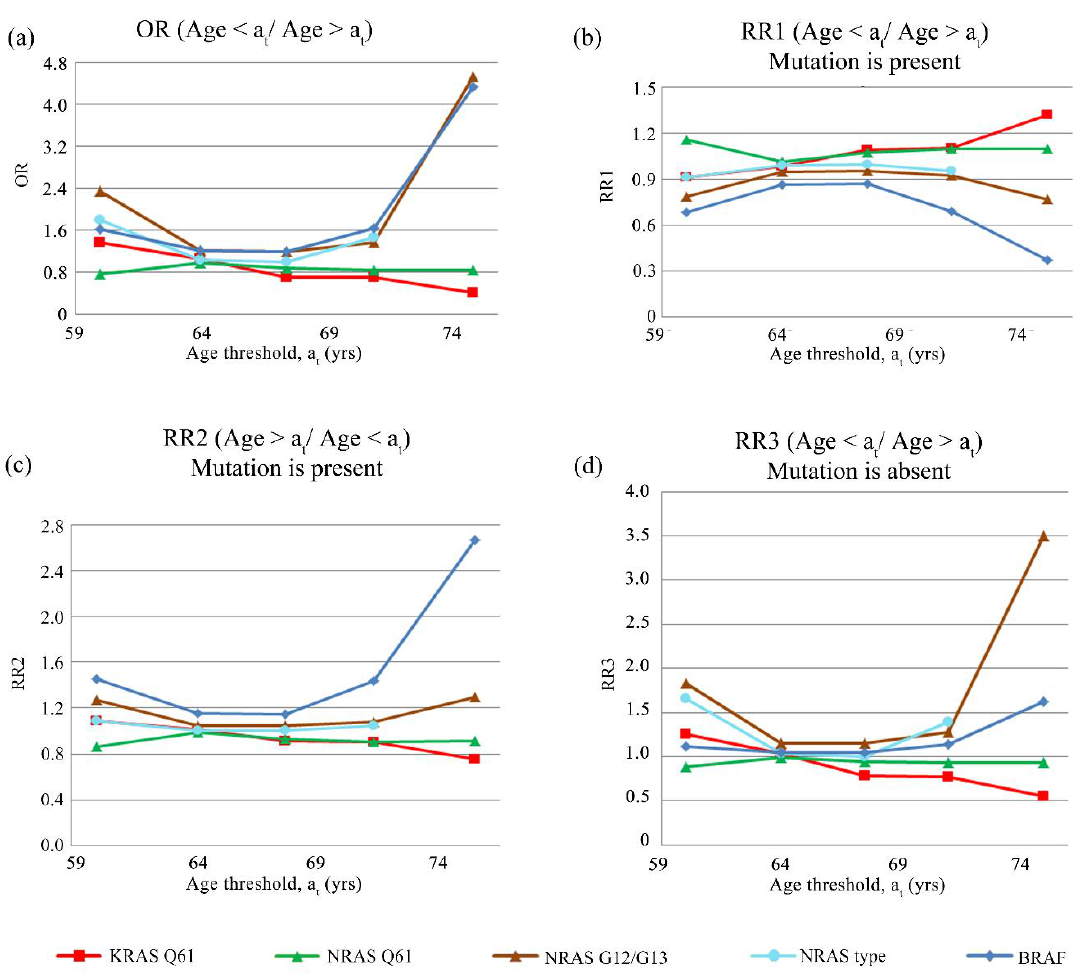
Figure 3. Association between age and mutational status. On the horizontal axis are presented the various threshold ages (a t ) by which the cohort was divided into two groups: 1—patients younger than the threshold ages, and 2—patients older than the threshold ages. These values represent the percentiles 25%, 33%, 50% (or median), 67%, and 75% of the “age” variable. The association was illustrated by the calculated OR ( a ), RR1 ( b ), RR2 ( c ), and RR3 ( d ).